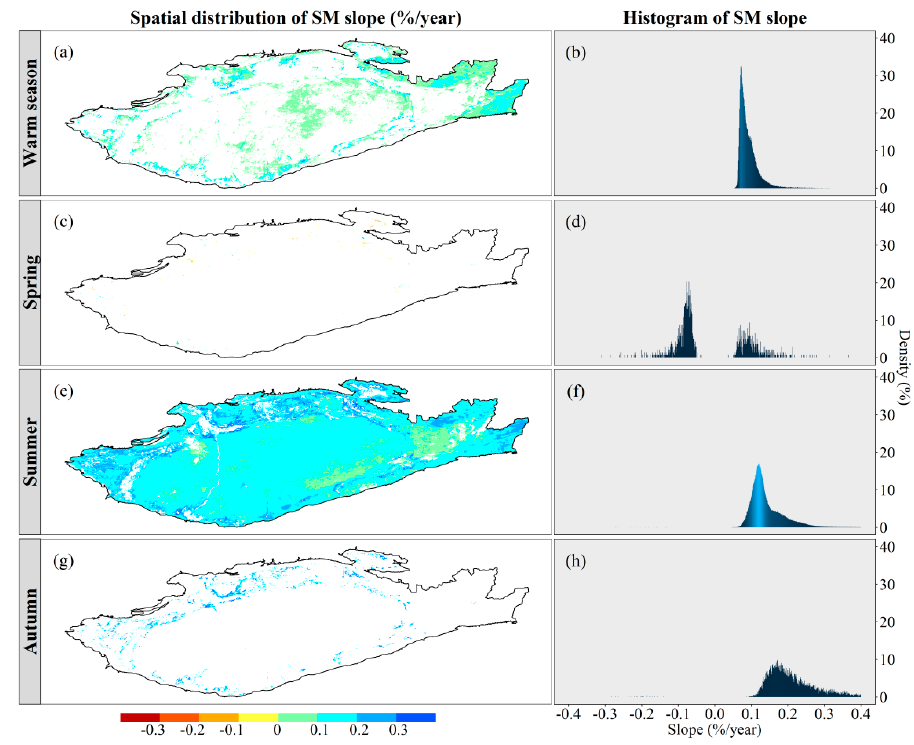
Figure 7. The spatial distributions and histograms of significant slope ( p < 0.05) for soil moisture in the warm season ( a , b ); spring ( c , d ); summer ( e , f ) and autumn ( g , h